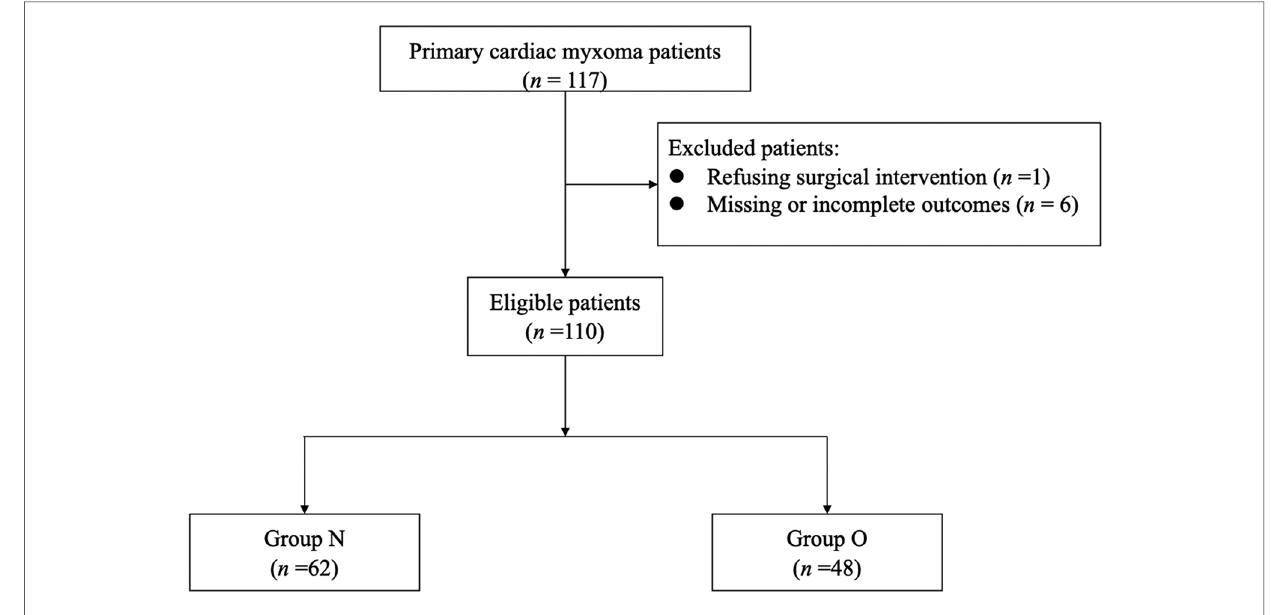
FIGURE 1 Patient